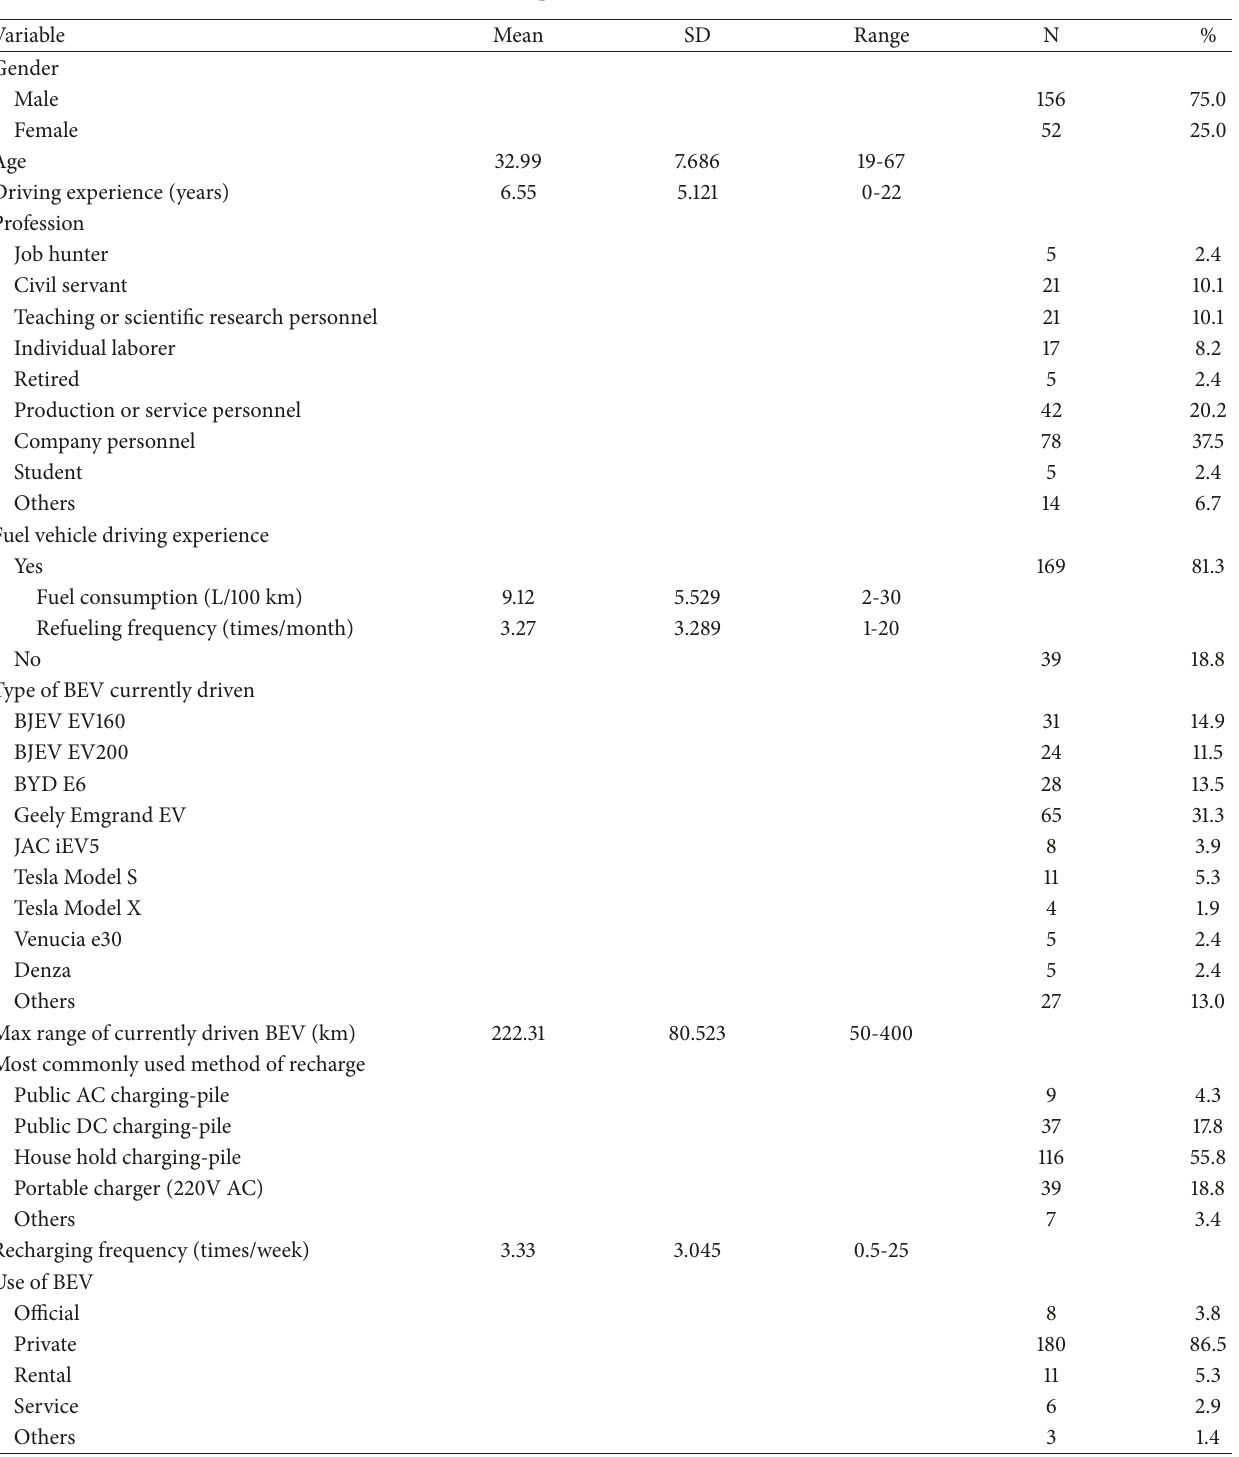
Table 1: Sample characteristics (N =